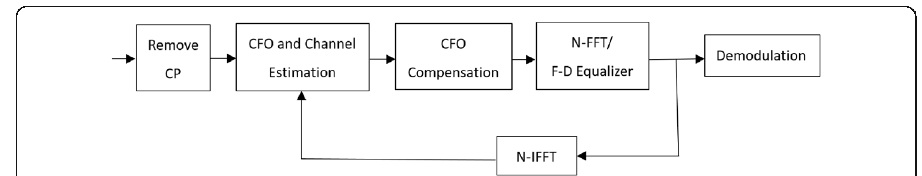
Fig. 3 Processing diagram of the proposed MIMO-OFDM receiver